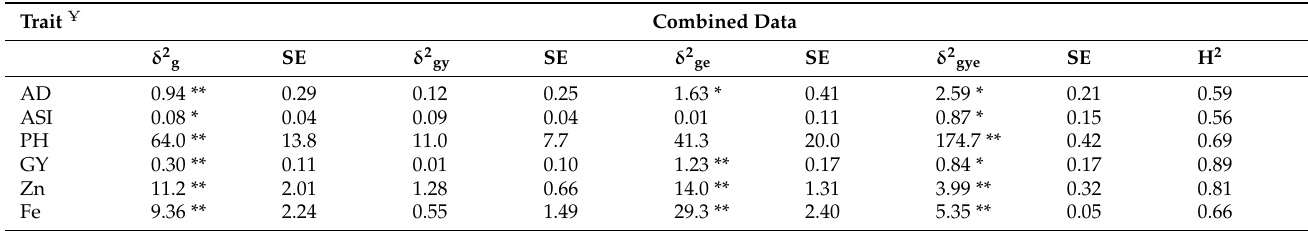
Table 4. Genotypic variance ( δ 2 g ), Genotype × Year ( δ 2 gy ), Genotype × Environment ( δ 2 ge ),